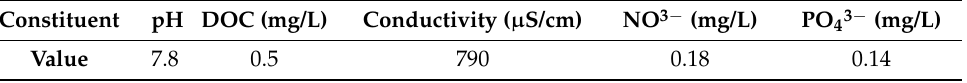
Table 1. Major characteristics of the dechlorinated natural potable water used for the experiments. Constituent pH DOC (mg/L) Conductivity ( µ S/cm) NO 3 − (mg/L) PO 43 − (mg/L) Value 7.8 0.5 790